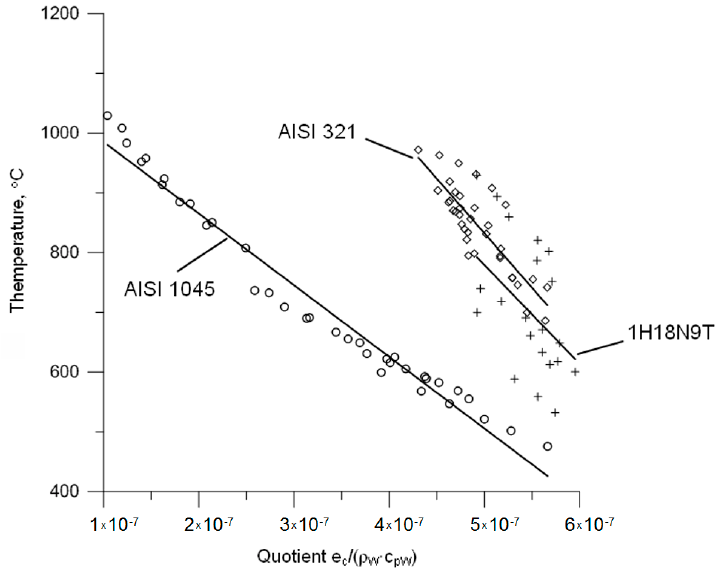
Figure 8. The progress of changes of the average contact temperature versus the quotient e c /( ρ W · c pW ).